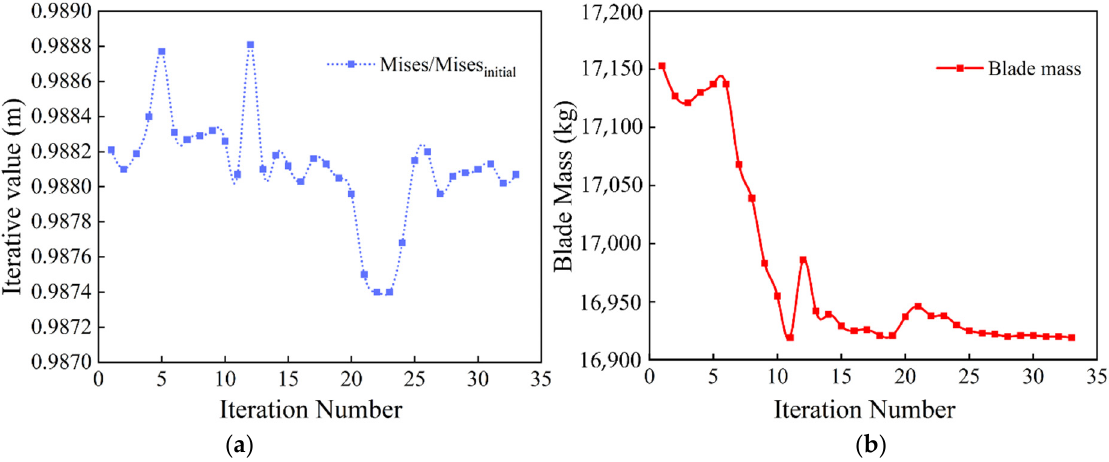
Figure 7. Design variables during optimization: ( a ) the change of Mises stress during iteration; ( b ) the value of blade mass during iteration.